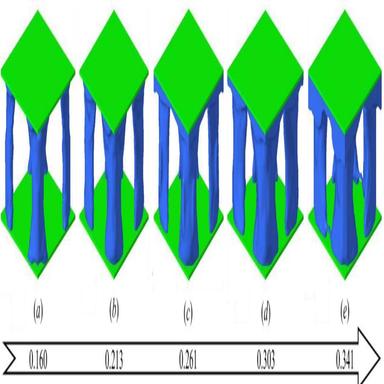
FE model of the 3 × 3 × 3 CLL material with 27 repeated unit cells: (a) a 3 × 3 × 3 CLL material; (b) a unit cell; (c) local view of the A-A section; (d) local view of the B-B section.